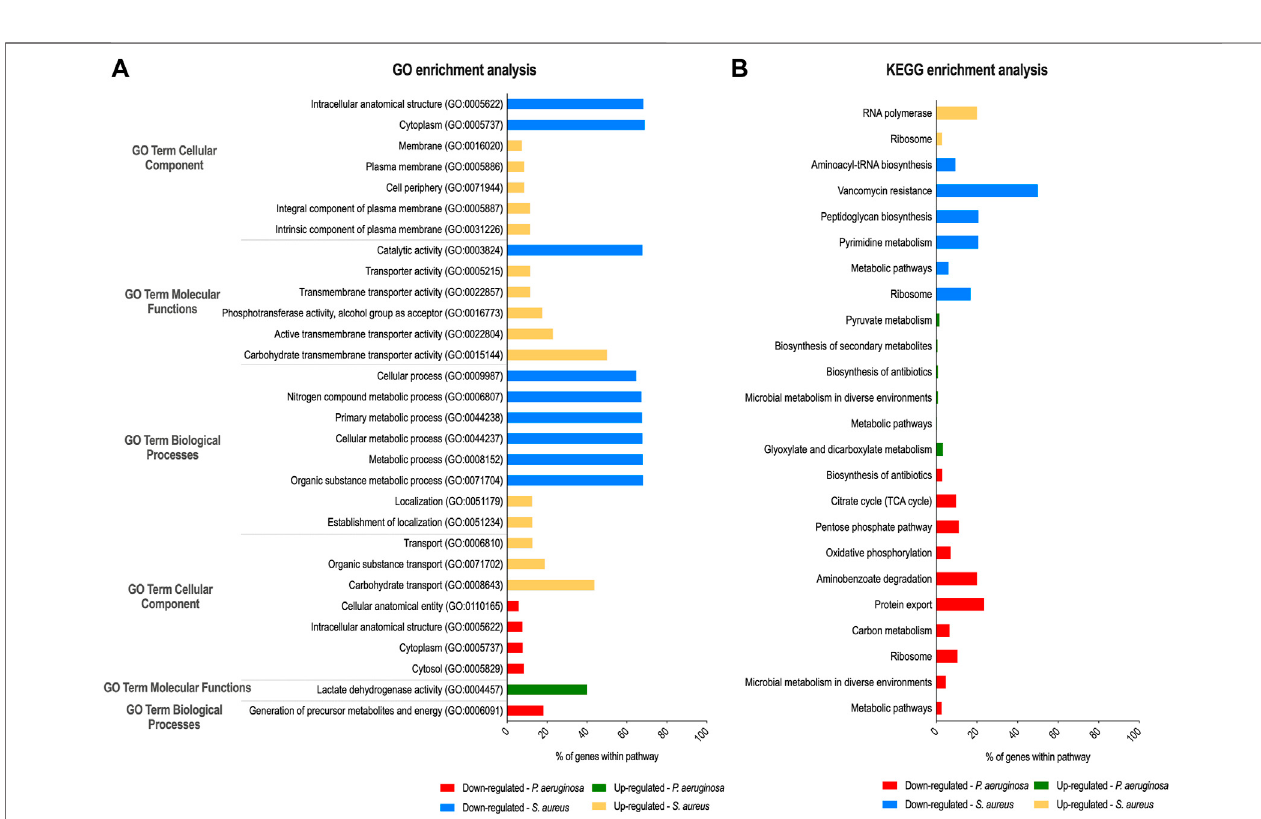
FIGURE 1 | Gene ontology (GO) and Kyoto Encyclopedia of Genes and Genomes (KEGG) enrichment analysis of P. aeruginosa and S. aureus after dual-species bio fi lm growth. GO (A) and KEGG pathways (B) analyses were performed to identify, respectively, biological processes and pathways signi fi cantly enriched within differentially expressed genes in S. aureus and P. aeruginosa